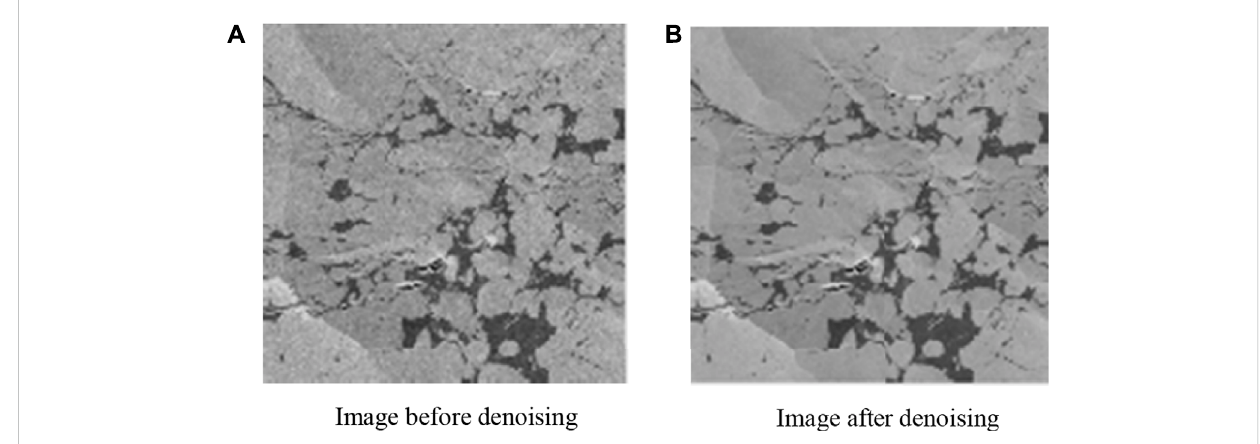
FIGURE 1 SEM scanning images of deep shale core in Luzhou block fl ow (A) before denoising and (B) after denoising.